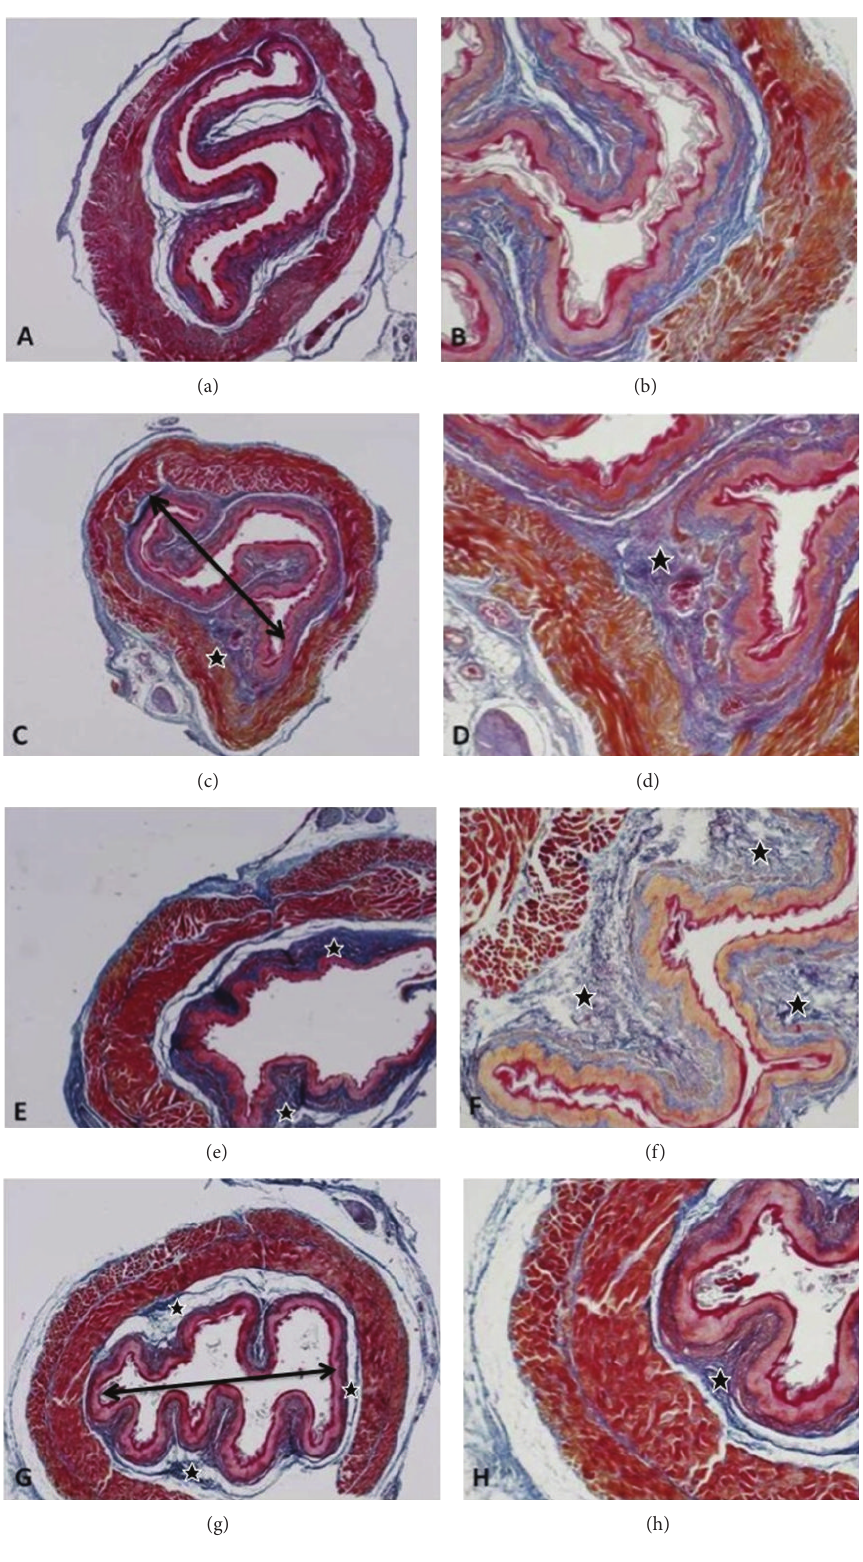
Figure 3: In the sham group, the normal histologic structure is visualized ((a)-(b)). The corrosive burn group demonstrates a constricted lumen (double arrow) and increased submucosal connective tissue ( 󳀅 ), ((c)-(d)). And also, the prednisolone-treated group demonstrates persistent histological changes with increased submucosal connective tissue ((e)-(f)) like the corrosive burn group. The BAPN-treated group demonstrates histological findings that are similar to the sham group ((g)-(h)). All the samples were stained with Azan and magnifications are × 10 for (a), (c), (e), and (g) and × 40 for (b), (d), (f), and